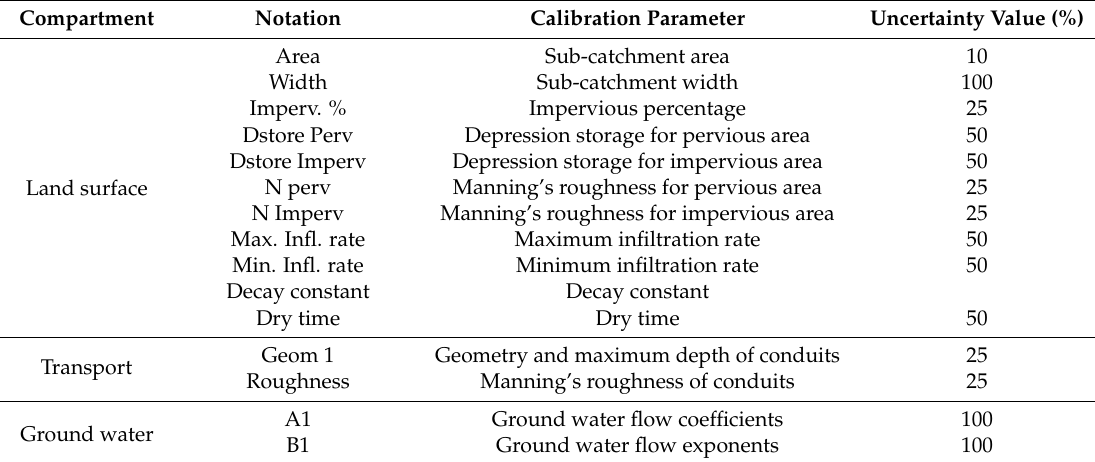
Table 1. Calibration parameters and assigned uncertainties in